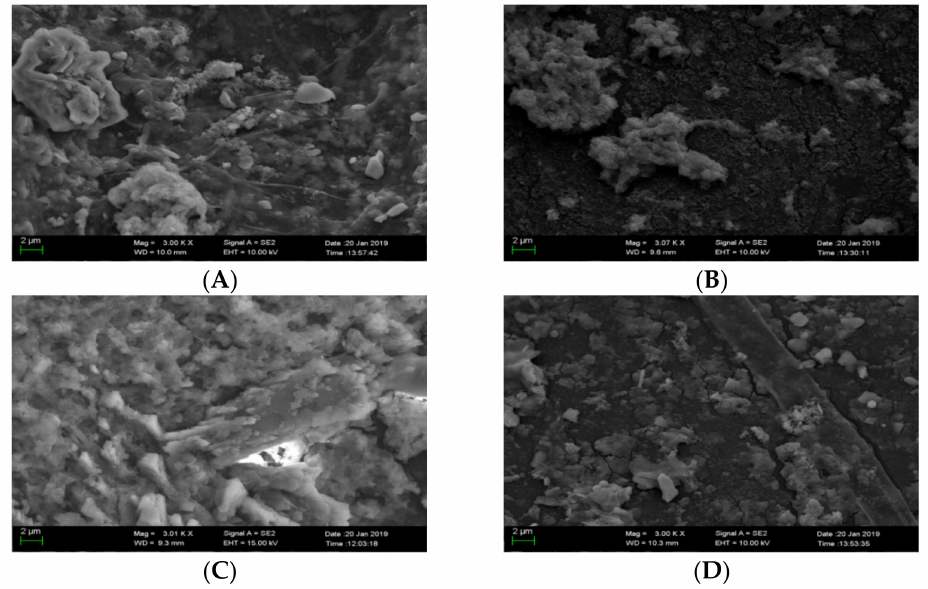
Figure 3. The appearance of scaling (( A ) M0F1, ( B ) M1F1, ( C ) M0F3, ( D )